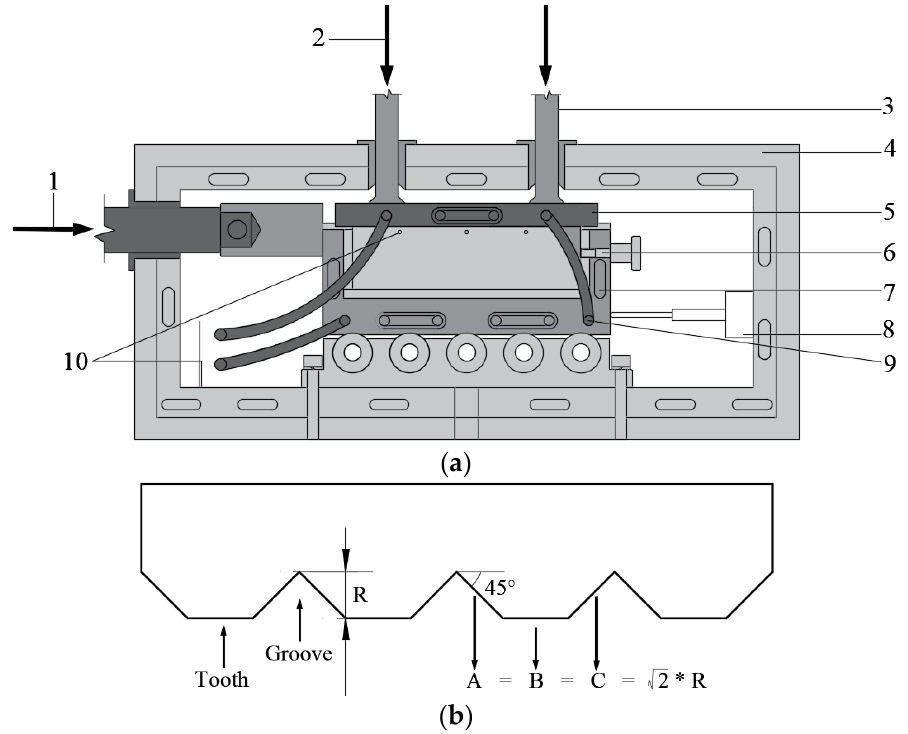
Figure 2. Schematic diagrams of the DDJ-1G. ( a ) Loading systems in the DDJ-1G; ( b ) schematic diagram of the shear plate surface, showing (1) horizontal loads; (2) vertical loads; (3) structural panel; (4) environmental chamber; (5) shear plate; (6) inner box; (7) shear box; (8) displacement transducers; (9) main circulation channels to supply refrigerated coolant; (10) temperature sensor.